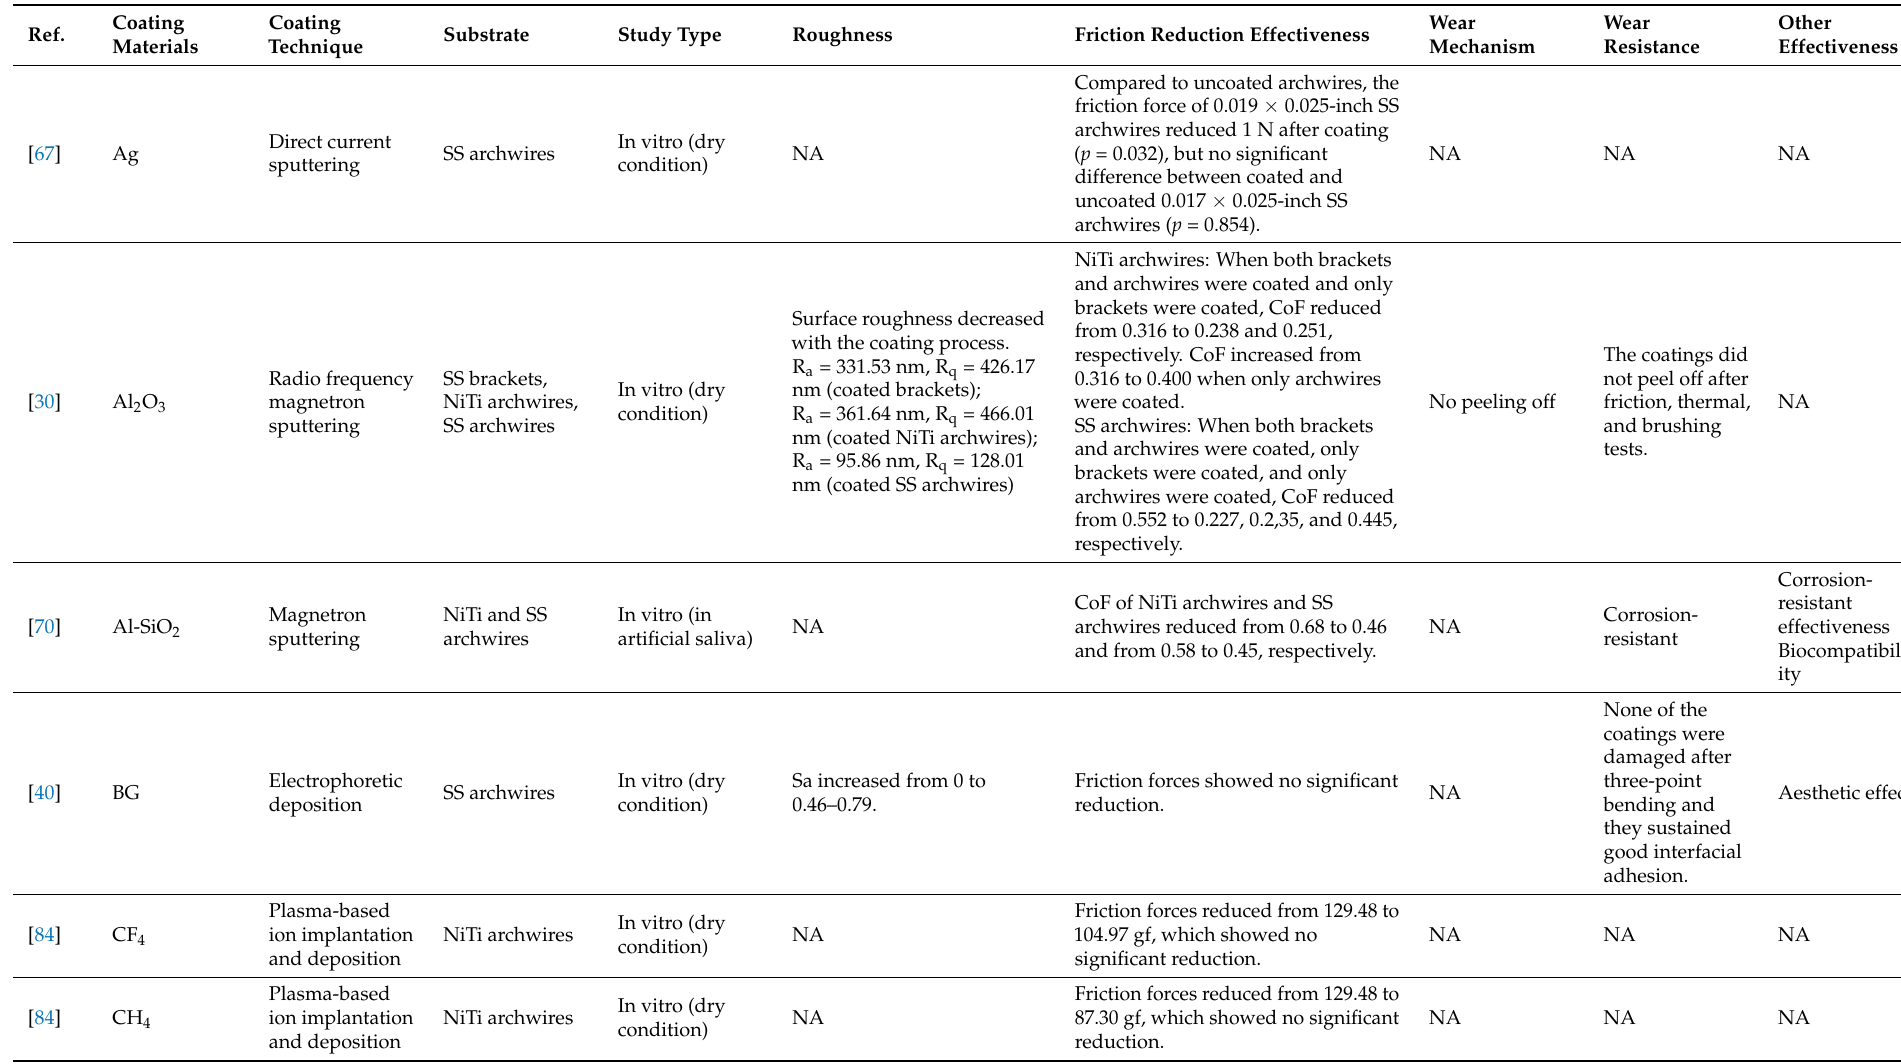
Table 1. Recent studies on friction reduction coatings for orthodontic